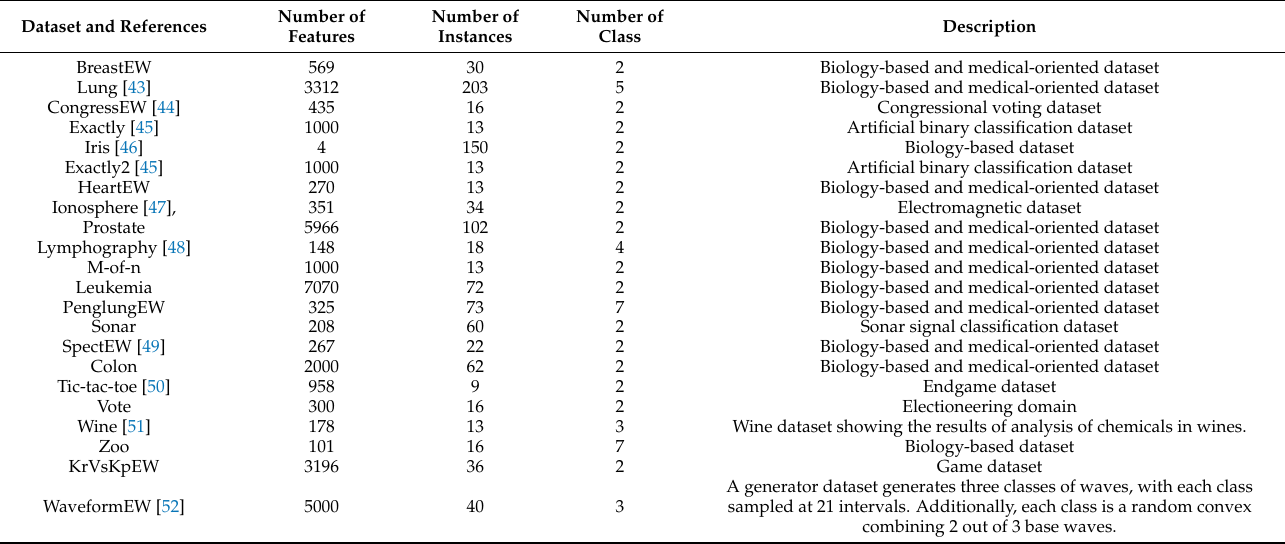
Table 1. Datasets and their corresponding details, such as the number of features, classes and instances, and a description of